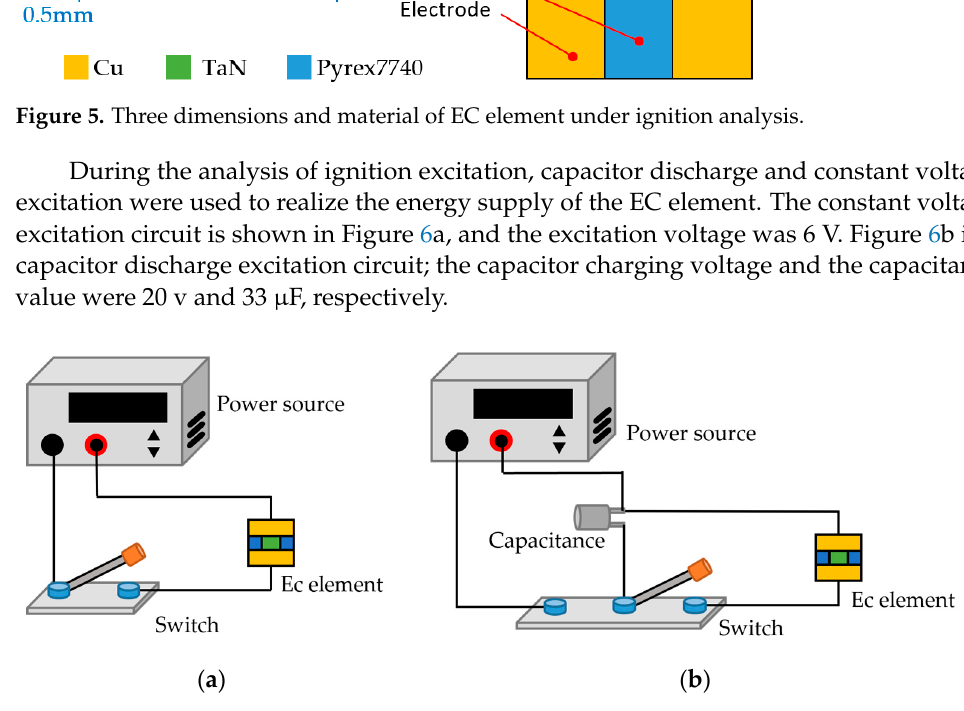
Figure 6. External excitation circuit. ( a ) Constant voltage excitation; ( b ) Capacitor discharge excitation.